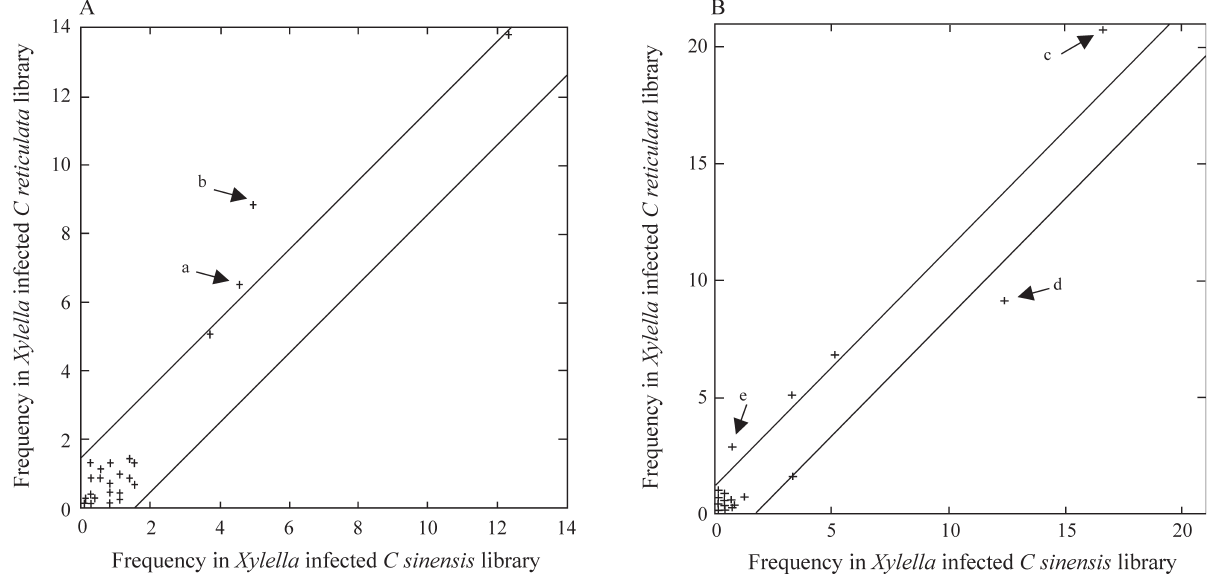
Figure 5 - PlotCorr analyses for comparison between C. sinensis (x-axis) and C. reticulata (y-axis) normalized expression for photosystems (A) and car- bon fixation (B) related sequences. In (A) dots represent (a) oxygen-evolving complex 25.6 kD protein; (b) chlorophyll a/b-binding protein 151 LHCII type II CAB-151; in (B) (c) ribulose bisphosphate carboxylase/oxygenase activase; (d) ribulose bisphosphate carboxylase small chain; and (e) transketolase. Scales are in reads per thousand per library. Differential expression between libraries were significant only for ribulose bisphosphate carboxylase small chain (d) (p =